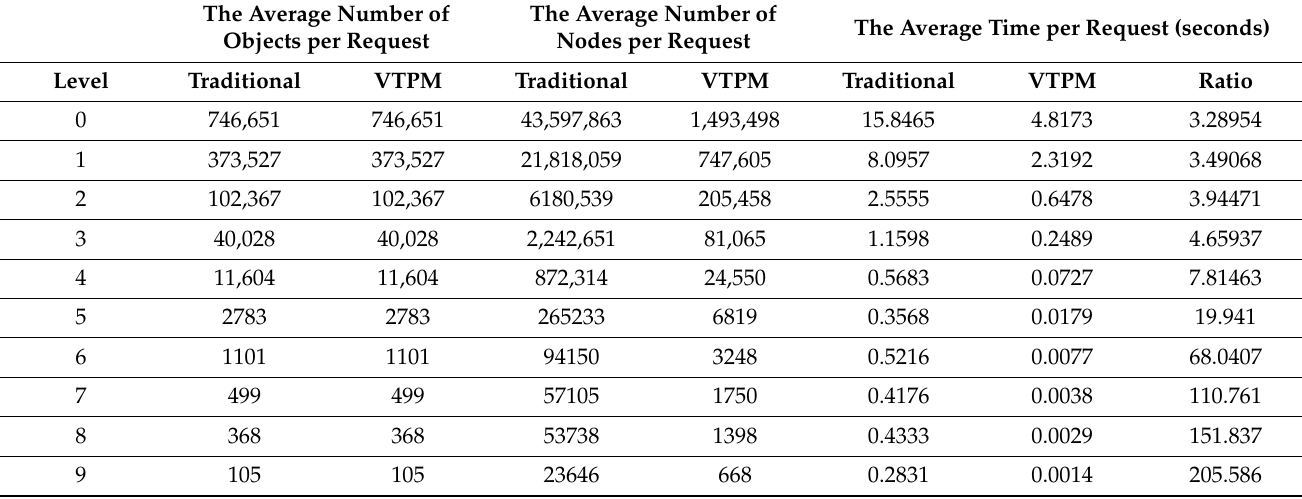
Table 5. Comparing the two schemes for obtaining requested